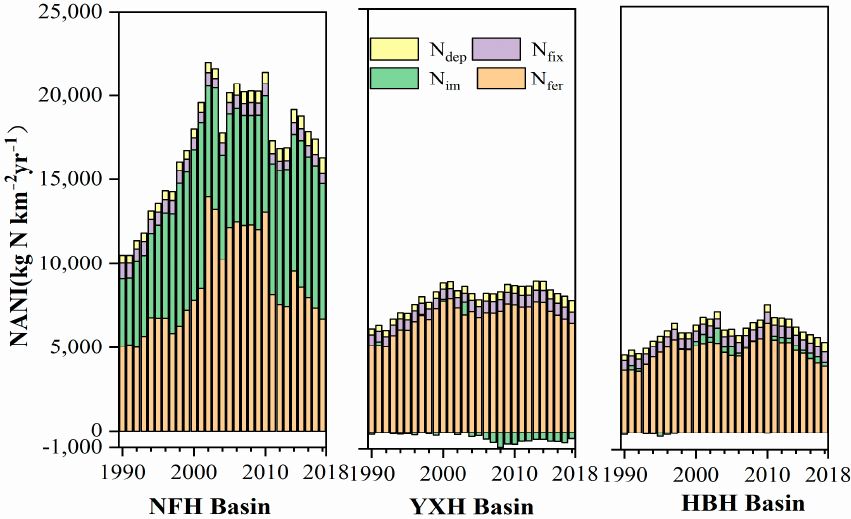
Figure 6. Characteristics of nitrogen input in three sub-catchments from 1990 to 2018 (We used the sub-basin boundary to assess the NANI by county according to the area ratio.).